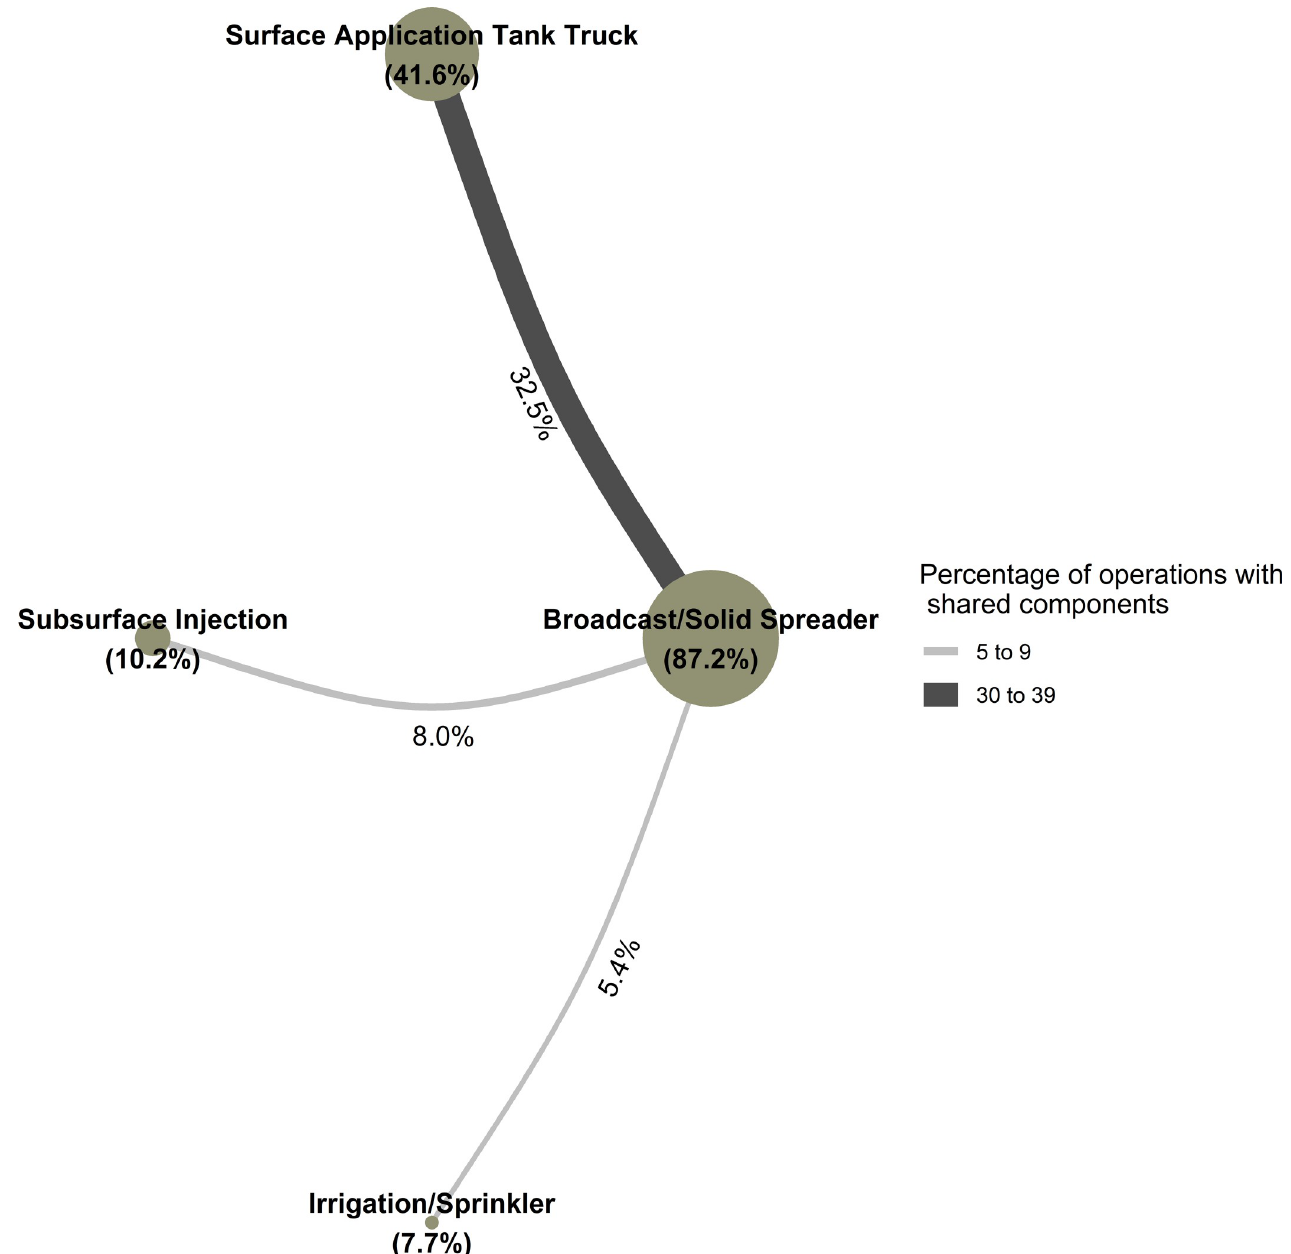
Fig 3. Network graph showing, for the 98.3 percent of operations that applied manure to land owned or rented by the operation, the percentage of operations practicing the given manure application strategy (diameter of nodes) and the percentage of operations practicing a pair of strategies together (width of edges, with widths colored by group based on magnitude of percentage). Edges representing percentages of five or less were suppressed.